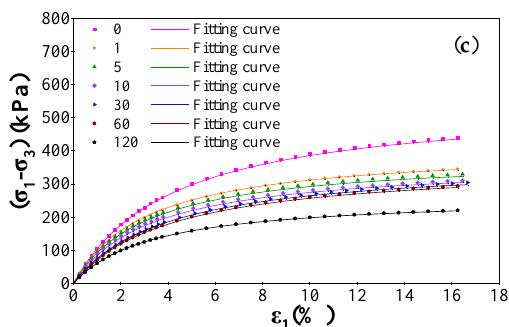
Figure 9. Comparison of fitting model values with experiment values (taking samples with 0.5% salt content as an example): ( a ) σ 3 = 100 kPa; ( b ) σ 3 = 200 kPa; ( c ) σ 3 = 300 kPa.